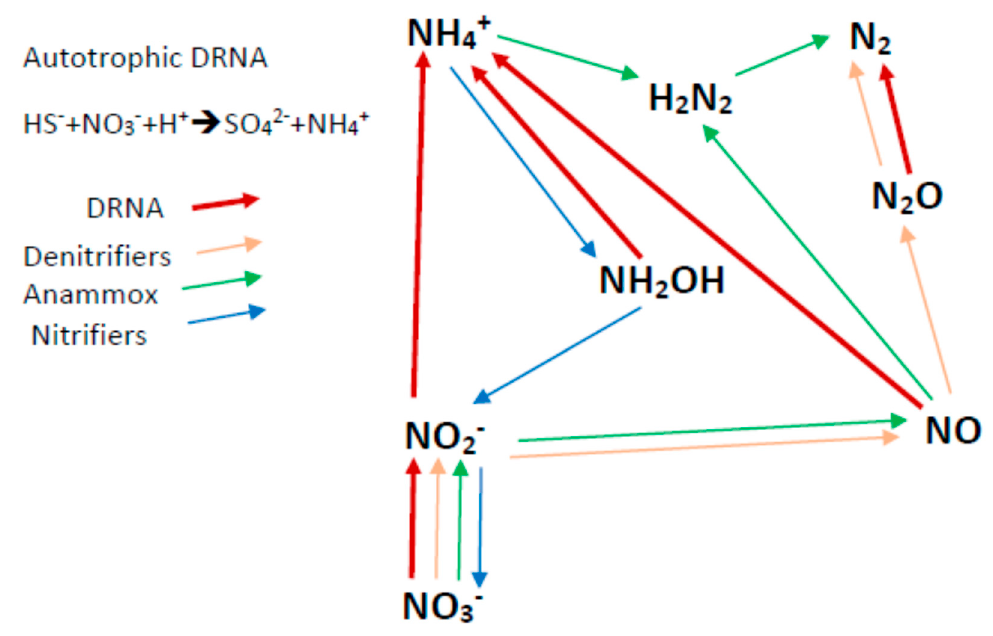
Figure 1. Nitrogen cycle pathways important to the dissimilatory nitrate reduction to ammonium (DNRA) process [43].